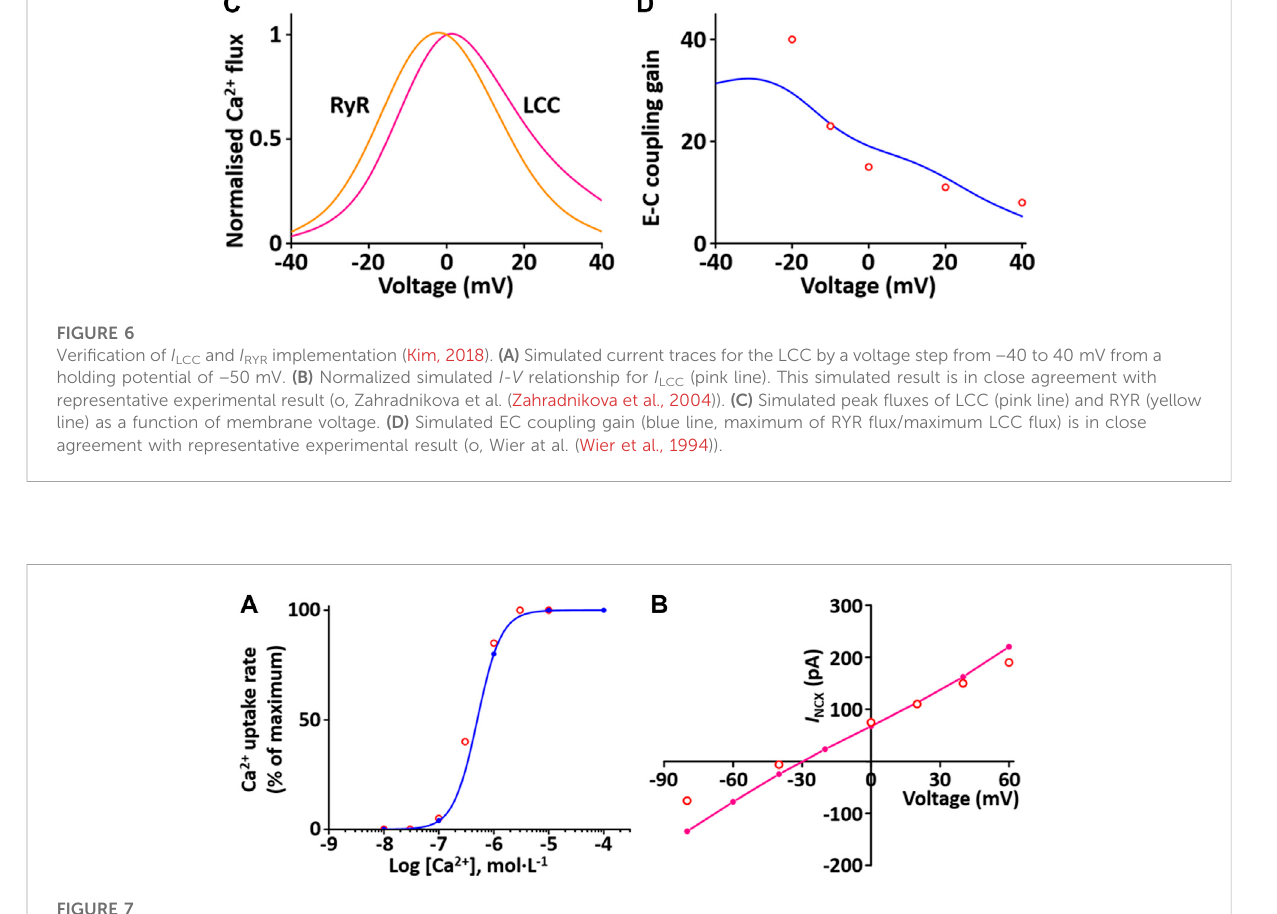
FIGURE 7 Veri fi cation of I SERCA and I NCX implementation (Kim, 2018). (A) The Ca 2+ dependence of the relative rate of simulated SERCA activity is well plotted (blue line). This result is close agreement with representative experimental values (o, Lytton et al. (Lytton et al., 1992)). (B) Simulated I-V relationship for the NCX (pink line). This result is close agreement with representative experimental values (o, Li et al.,